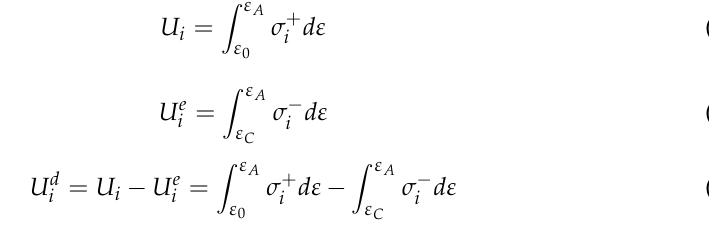
Table 1. The proportions of AE energy in AE period under different stress paths.